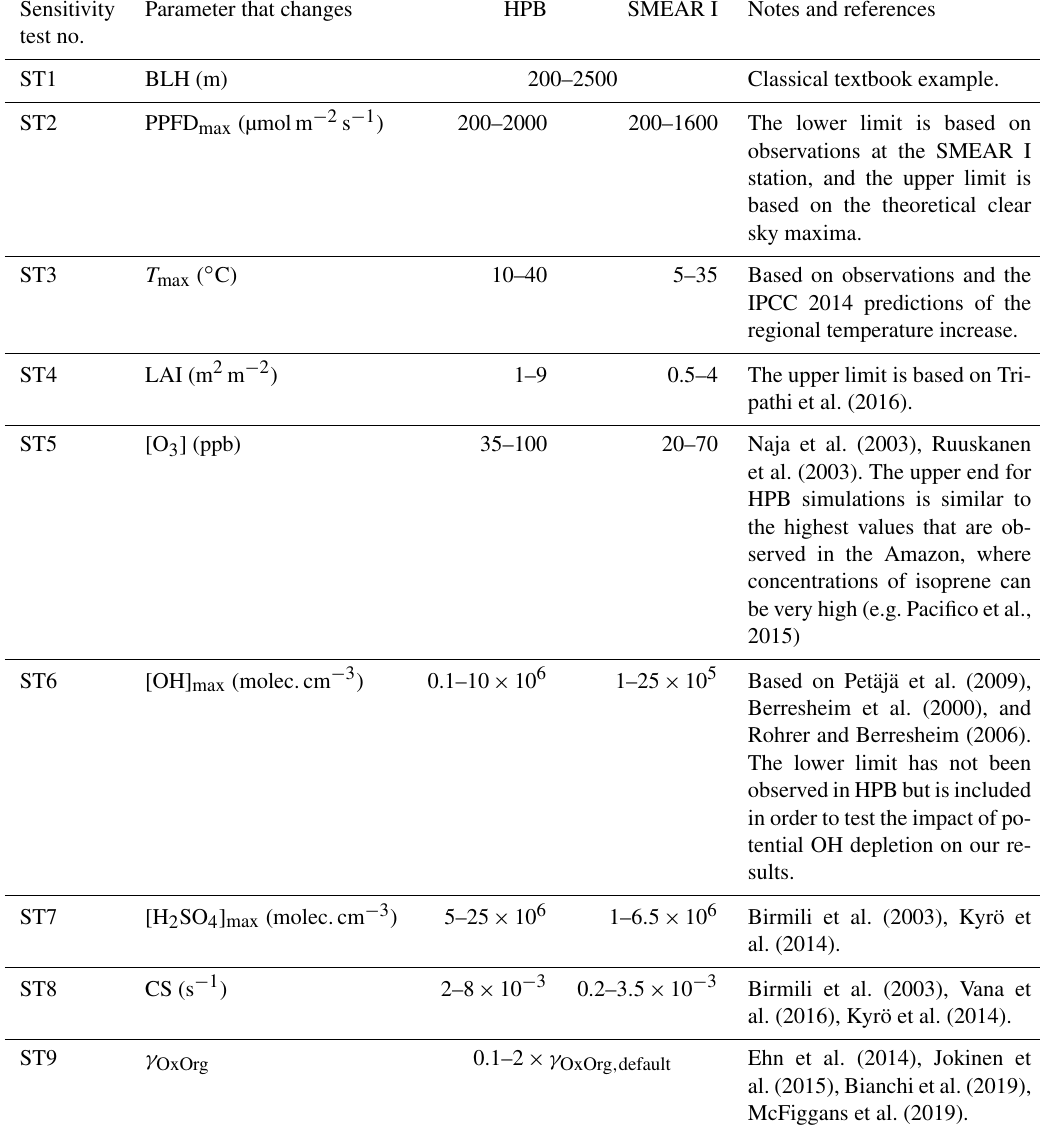
Table D1. Constrained parameters for sensitivity tests and their range of values. Nine different sensitivity tests (ST1–9) were conducted for all plant species and infections, and only one parameter was changed at a time between these test. BHL is the planetary boundary layer height, PPFD max is the daily maximum photosynthetic photon flux density, T max is the maximum daily temperature, LAI is the leaf area index of non-infested leaves, CS is the condensation sink, and γ OxOrg is the yield of OxOrg. HPB and SMEAR I refer to simulations conducted under Hohenpeißenberg (i.e. oak and poplar) and SMEAR I (i.e. birch) conditions,